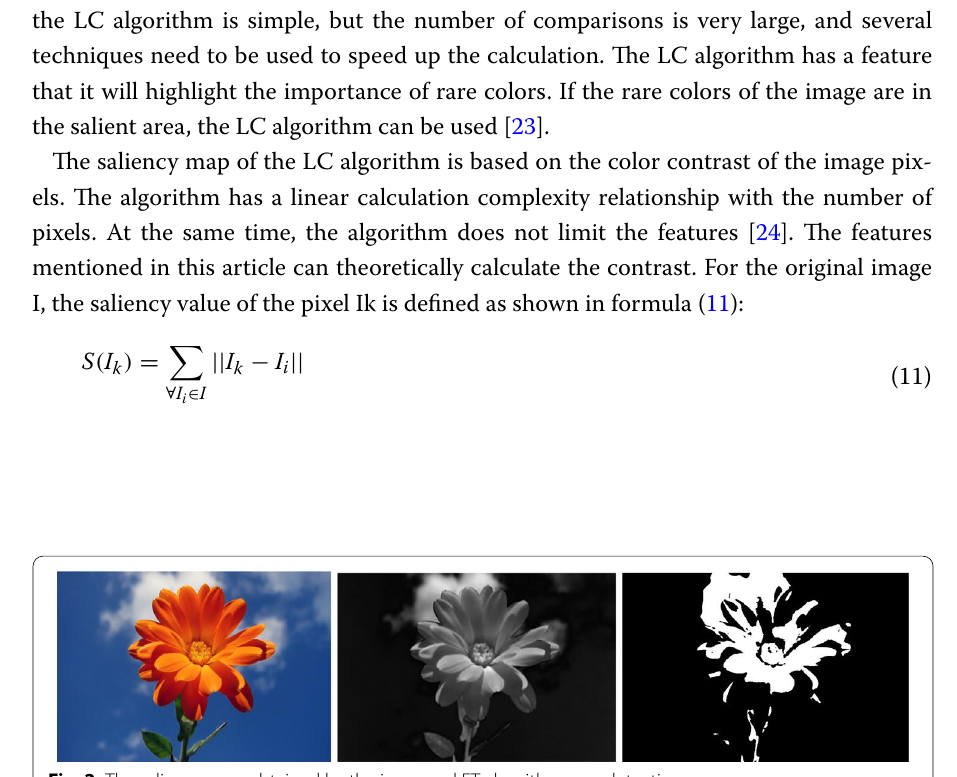
Fig. 2 The saliency map obtained by the improved FT algorithm area